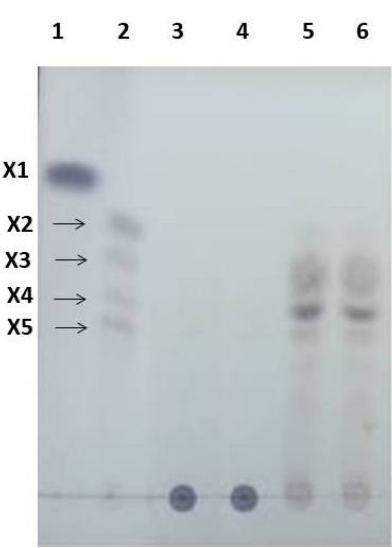
Figure 1. TLC chromatogram of XOS after enzymatic hydrolysis of cassava pulp xylan by endo-1.4- D-xylanase (in lanes 5 and 6), xylotetraose being the major product. Standard XOS: X1 (lane 1); and mixtures X2–X5 (lane 2). The control from the inactive enzyme (lanes 3 and 4). Quantitative analysis by HPLC (Figure 2) revealed the concentrations of XOS in hy- drolysate to be 7.43, 89.80, 35.17 and 5591.15 ppm for xylobiose (X2), xylotriose (X3), xylo- tetraose (X4) and xylopentaose (X5), respectively. Figure 2. HPLC chromatogram of XOS from enzymatic hydrolysis of cassava pulp xylan by endo- 1.4-D-xylanase, Xn indicates the xylose subunits in the oligomers.